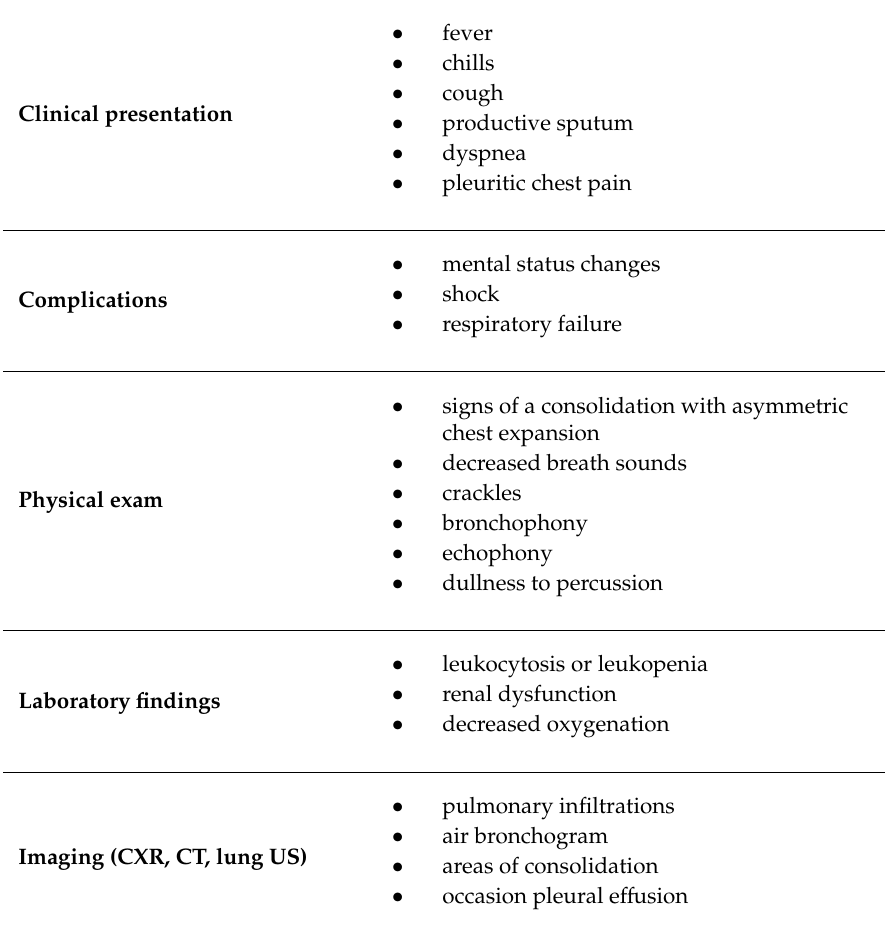
Table 1. Pneumococcal pneumonia in humans.